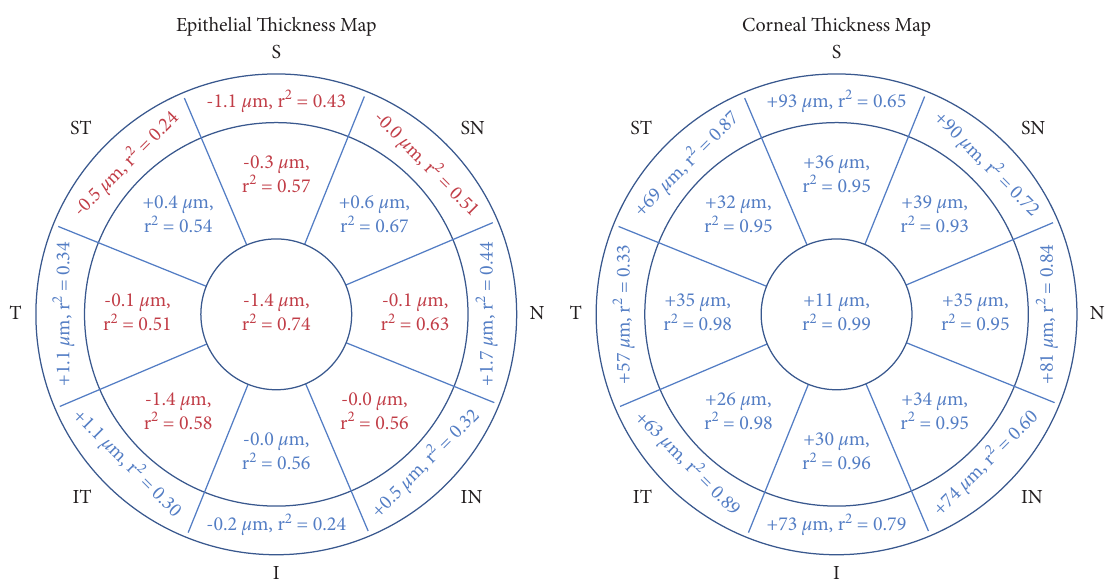
Figure 2: Differences and correlation between Enhanced Spectral-Domain-OCTmeasurements and Spectral-Domain-OCTmeasurements of the epithelial and corneal thicknesses in the 6 mm